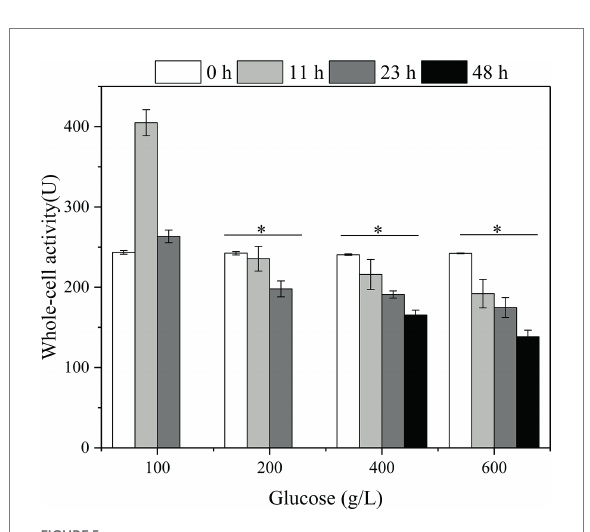
FIGURE 5 The effect of glucose titers on the whole-cell activity of the G. oxydans ( * p < 0.05).